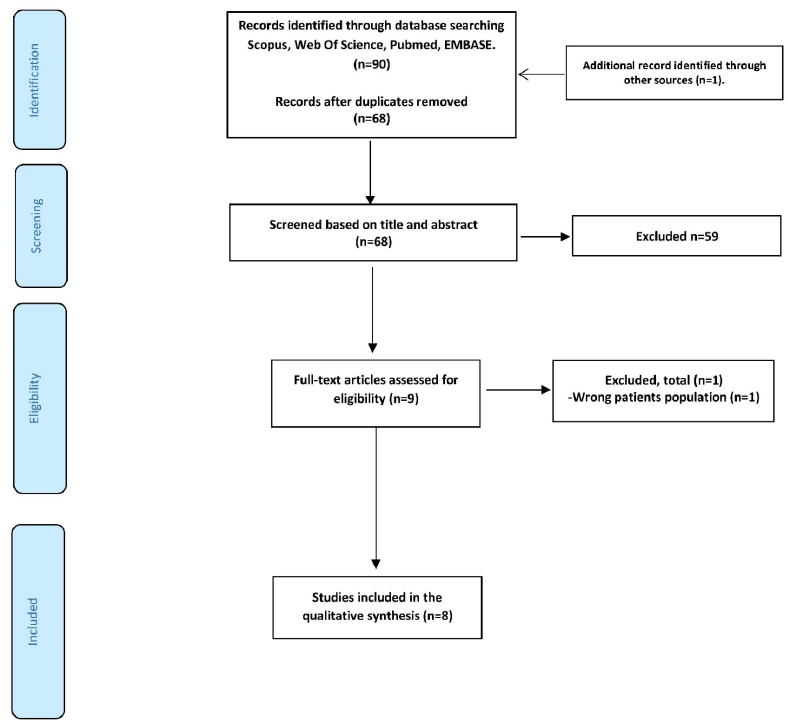
Figure 1. Methodological quality for the included